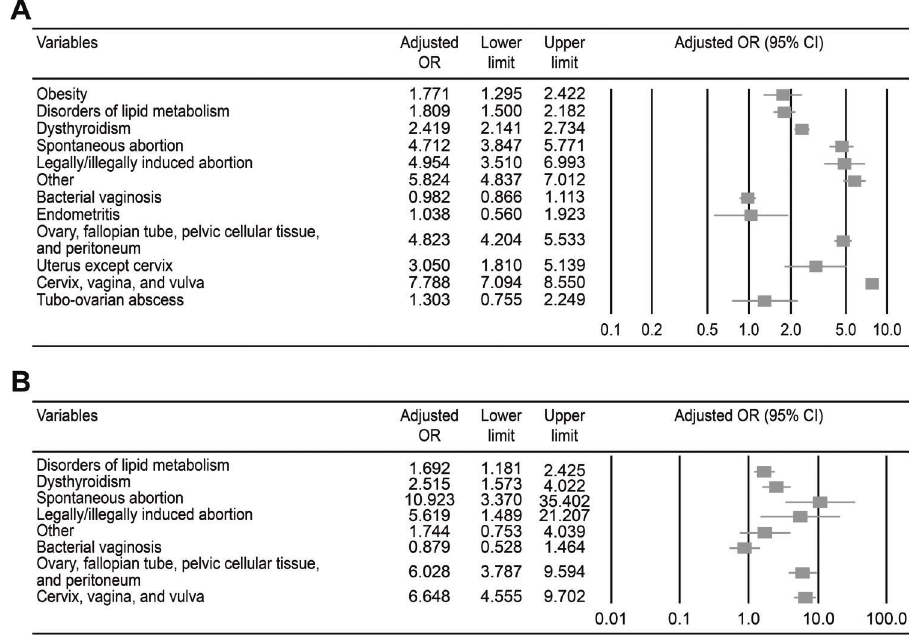
Figure 2 - The results of the multivariate logistic regression analysis of risk factors associated with infertility. A) Women p 40 years old. B) Women 4 40 years old.